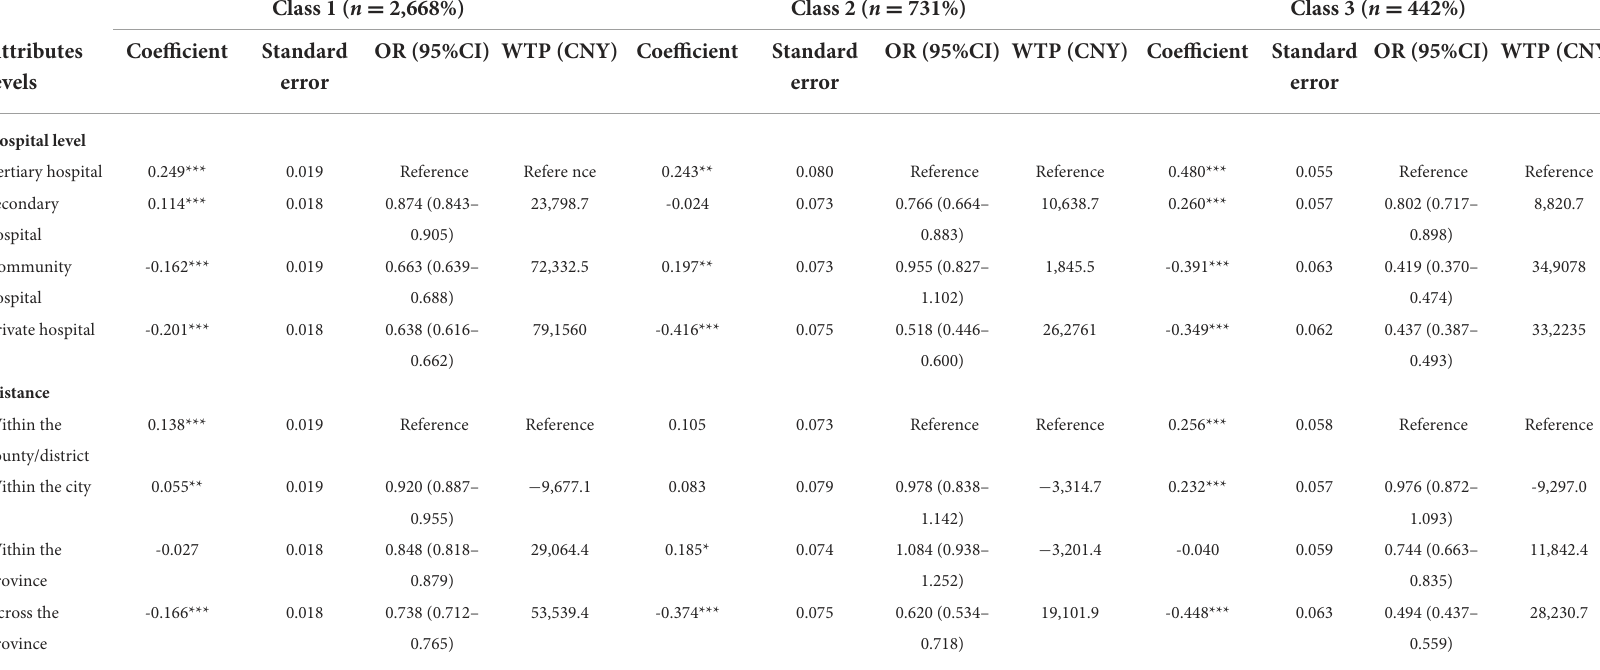
TABLE 9 Attributes and levels of acute infectious diseases